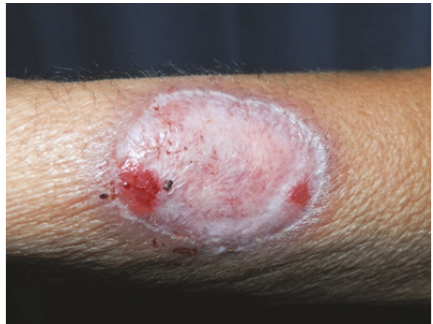
Figure 4: Ulcer on forearm after IVI Penicillin G